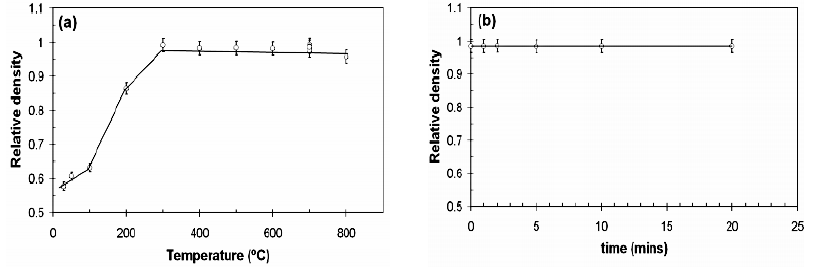
Figure 5. Relative density as a function of variable: ( a ) SPS temperature; ( b ) hold time. Reproduced with permission from [137].